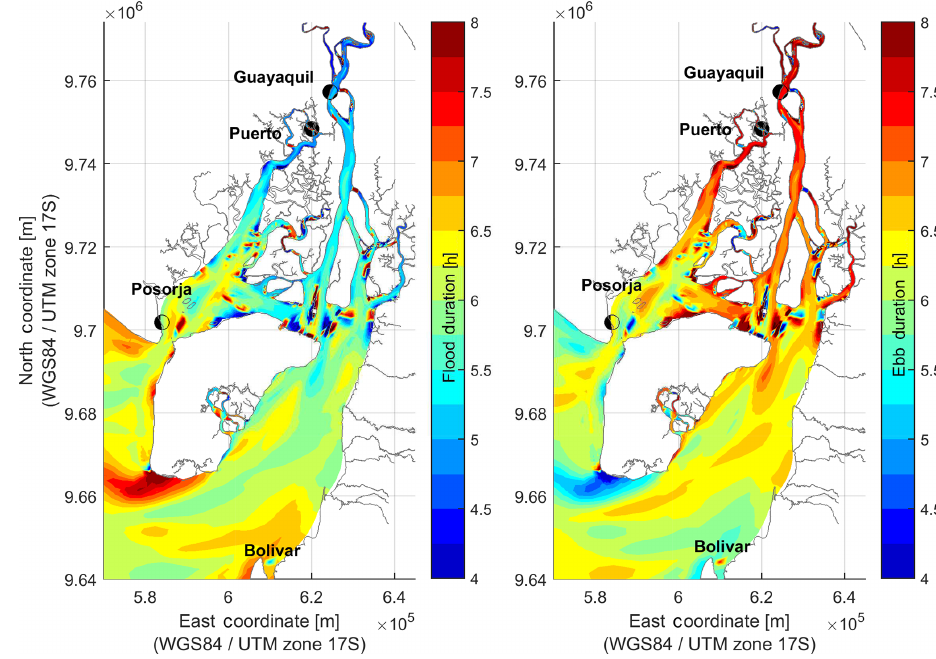
Figure 6. Duration of flood and ebb periods over a tidal cycle for the Gulf of Guayaquil.